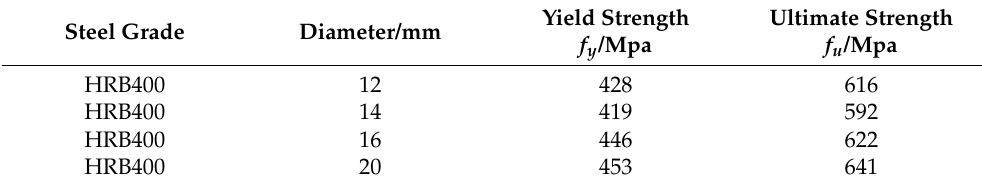
Table 1. Steel strength in the specimens.